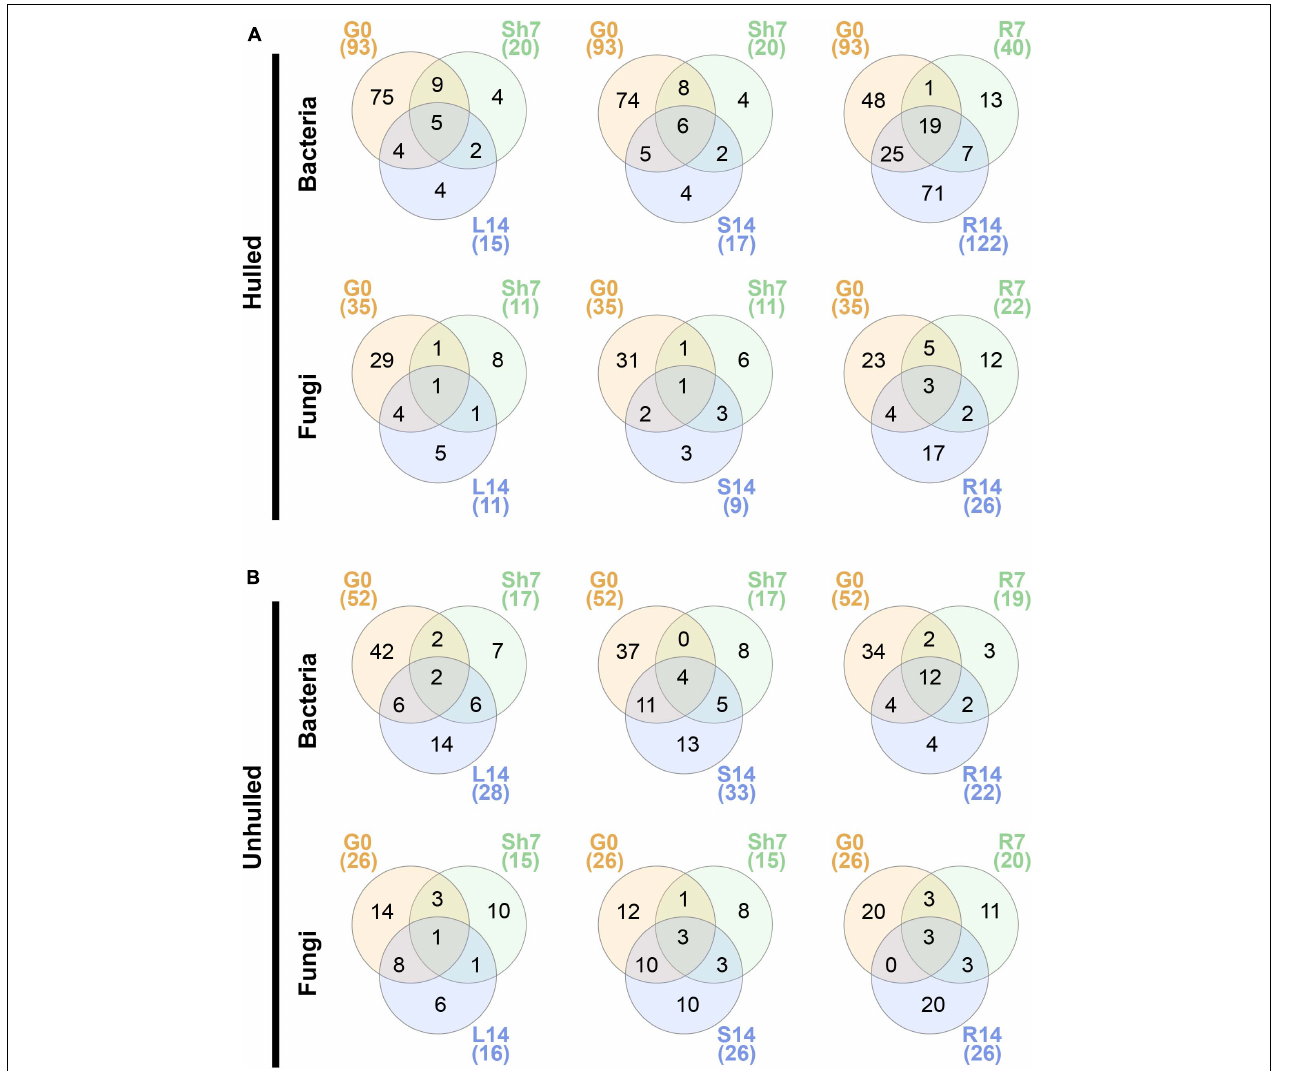
FIGURE 4 | Distribution of bacterial and fungal OTUs in seeds and seedling compartments. (A) Distribution of bacterial and fungal OTUs in hulled seeds and their seedlings. (B) Distribution of bacterial and fungal OTUs in unhulled seeds and their seedlings. Venn diagrams were constructed using InteractiVenn (http://www.interactivenn.net/). Each circle in the Venn diagrams represents a given sample. The numbers in parentheses indicate the total numbers of OTUs detected in each sample. The numbers on the Venn diagrams indicate the numbers of OTUs uniquely detected or co-occurring across different samples. Taxonomic information for OTUs co-occurring in seeds, 7-day-old seedlings, and 14-day-old seedlings is available in Supplementary Table 5 . G0, seed microbial community before planting; Sh7, microbial community of the shoot endosphere at 7 days after planting; R7, microbial community of the root endosphere at 7 days after planting; L14, microbial community of the leaf endosphere at 14 days after planting; S14, microbial community of the stem endosphere at 14 days after planting; and R14, microbial community of the root endosphere at 14 days after